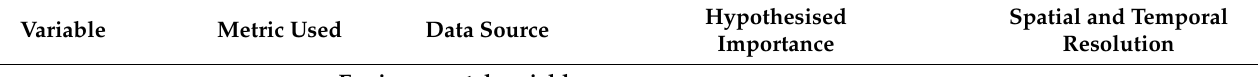
Table 1. List of environmental and operational variables for which data was collected during the Queensland SharkSmart drone trial, including the metric used and the hypothesized importance of each variable for influencing the probability of sighting